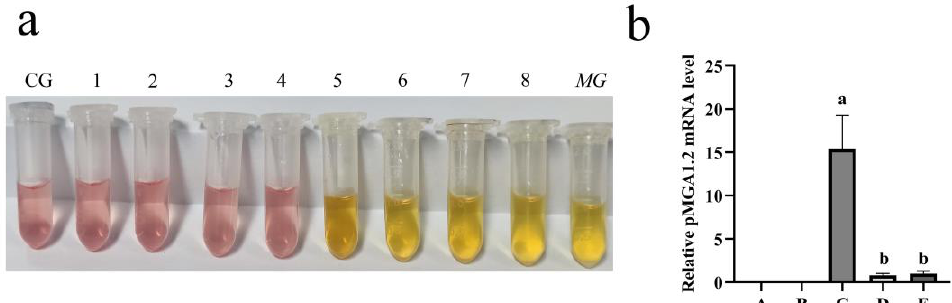
Figure 2. GA inhibited MG proliferation in vitro and pMGA1.2 expression in the broilers’ lungs. ( a ) GA inhibited the proliferation of MG in vitro. CG: control group; 1: 250.00 µ g/mL; 2: 125.00 µ g/mL; 3:62.50 µ g/mL; 4: 31.25 µ g/mL; 5: 15.63 µ g/mL; 6: 7.81 µ g/mL; 7: 3.91 µ g/mL; 8: 1.96 µ g/mL; MG: MG-positive control group. ( b ) GA inhibited pMGA1.2 expression in the broilers’ lungs. A: control group, B: GA-alone treatment group, C: model group, D: Tia therapy group, E: GA therapy group. Bars with different lowercase letters represent significant differences ( p ≤ 0.05). Values represent the mean ± SD ( n = 3).